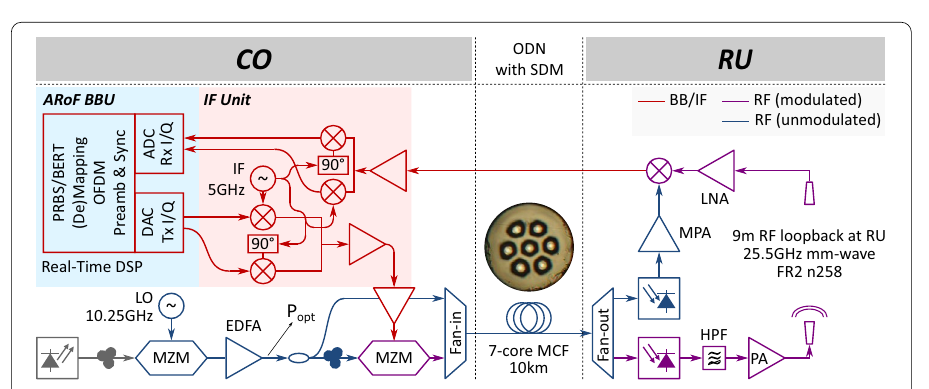
Fig. 4 Experimental setup for demonstration of mm-wave ARoF fronthaul with real-time processing of an 800 MHz wide 5G NR signal and a remote-fed LO. CO: central office, RU: remote unit, ARoF: analog radio-over-fiber, SDM: space division multiplexing, ODN: optical distribution network, 5G NR: 5G new radio, FR2: 5G NR frequency range 2, RF: radio frequency, IF: intermediate frequency, BB: baseband, BBU: baseband unit, DSP: digital signal processing, PRBS: pseudo random bit sequence, BERT: bit error rate tester, OFDM: orthogonal frequency division multiplexing, DAC: digital to analog converter, ADC: analog to digital converter, LO: local oscillator, MZM: Mach-Zehnder modulator, EDFA: erbium-doped fiber amplifier, MCF: multi-core fiber, HPF: high-pass filter, PA: power amplifier, MPA: medium power amplifier, LNA: